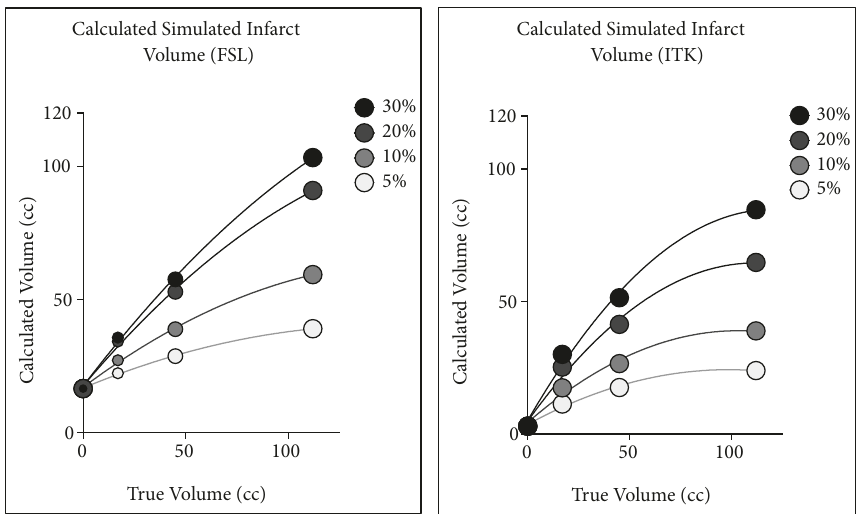
Figure3:Calculatedinfarctvolumeplottedagainsttrueinfarctvolume,for(3)differentinputvolumes(122cc,45cc,and17cc)and(4)different infarct densities (with density reduced by 5%, 10%, 20%, and 30%), FSL (left), ITK (right).